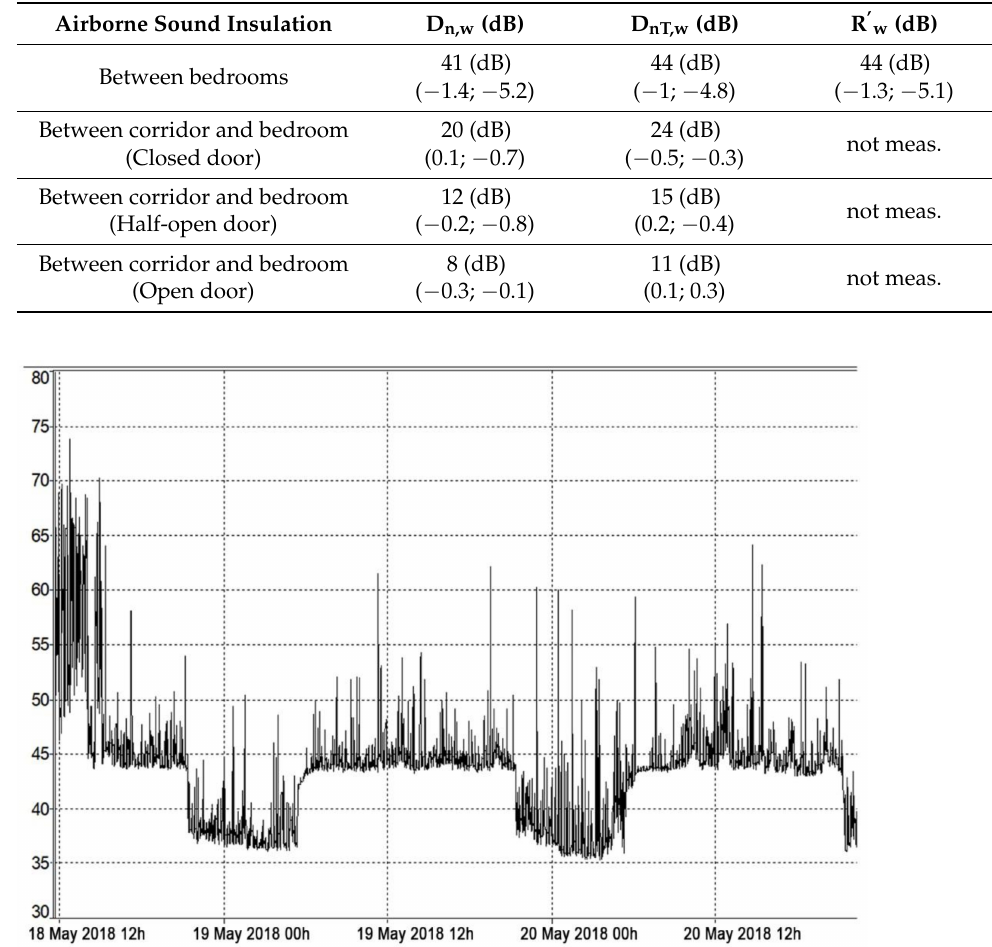
Figure 6. Standardized level difference between the room and the corridor in the configuration with the door closed, half-open, and completely open (D nT,w with closed door = 24 dB; D nT,w with half-open door = 15 dB; D nT,w with open door = 11 dB). Table 3. Single number values and spectrum adaptation terms of airborne sound insulation between the bedrooms and between the room and the corridor in the three configurations.